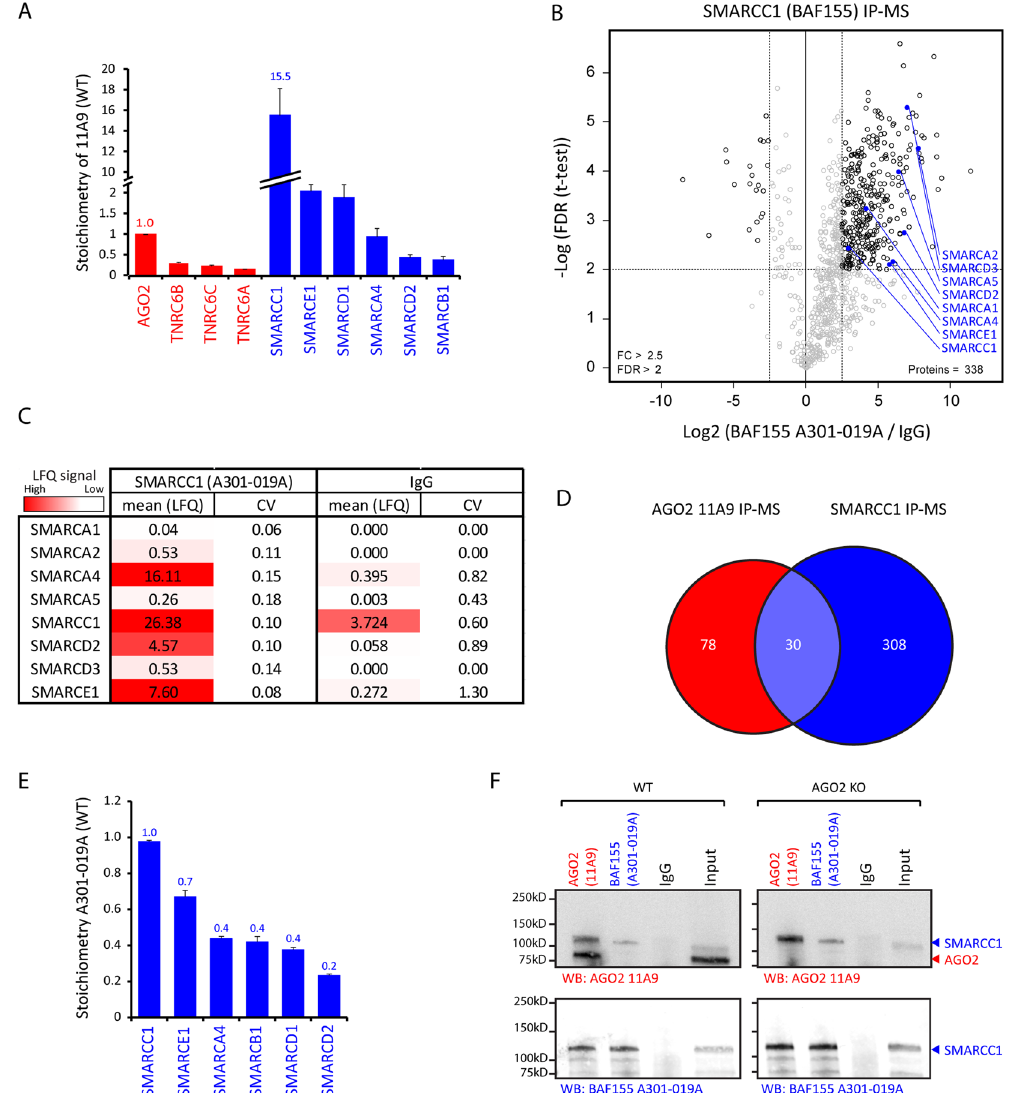
Figure 6. The 11A9 antibody may cross-react with SWI/SNF component SMARCC1/BAF155. ( A ) Stoichiometry analysis in HEK293T with iBAQ values generated with Maxquant normalized with the IgG isotype control. AGO2 is the bait and set at 1 as we used anti-AGO2 (11A9) for the IP. Error bars represent standard deviations of 3 individual IPs. ( B ) Label-free quantification of BAF155 A301-019A associated proteins compared to IgG control. Experiment was performed in triplicate in HEK293T cells. For the analysis a two sample T-test was applied. ( C ) Table with average Maxquant derived label free quantification intensities of 3 IP-MS experiments for BAF155 A301-019A and IgG with HEK293T wild type lysates. Mean LFQ values are times 10 billion and signals from AGO2 knock-out come from imputation. CV represents coefficient of variation. ( D ) Venn diagram representing the number of quantified and significant proteins in the SMARCC1 IP-MS and the AGO2 11A9 IP-MS and proteins that were quantified and significant in both experiments. ( E ) Stoichiometry analysis as in A with SMARCC1 as bait. SMARCC1 was set at 1 as we used anti-BAF155 (A301- 019A) for the IP. Error bars represent standard deviations of 3 individual IPs. ( F ) Reciprocal co-IPs with AGO2 11A9 and BAF155 antibodies with anti-IgG as negative control in Wildtype and AGO2 knock-out HEK293T cells. All samples were loaded on the same gel and transferred to the same blot on which both the staining’s were performed with different detection methods. Uncropped images are shown in the